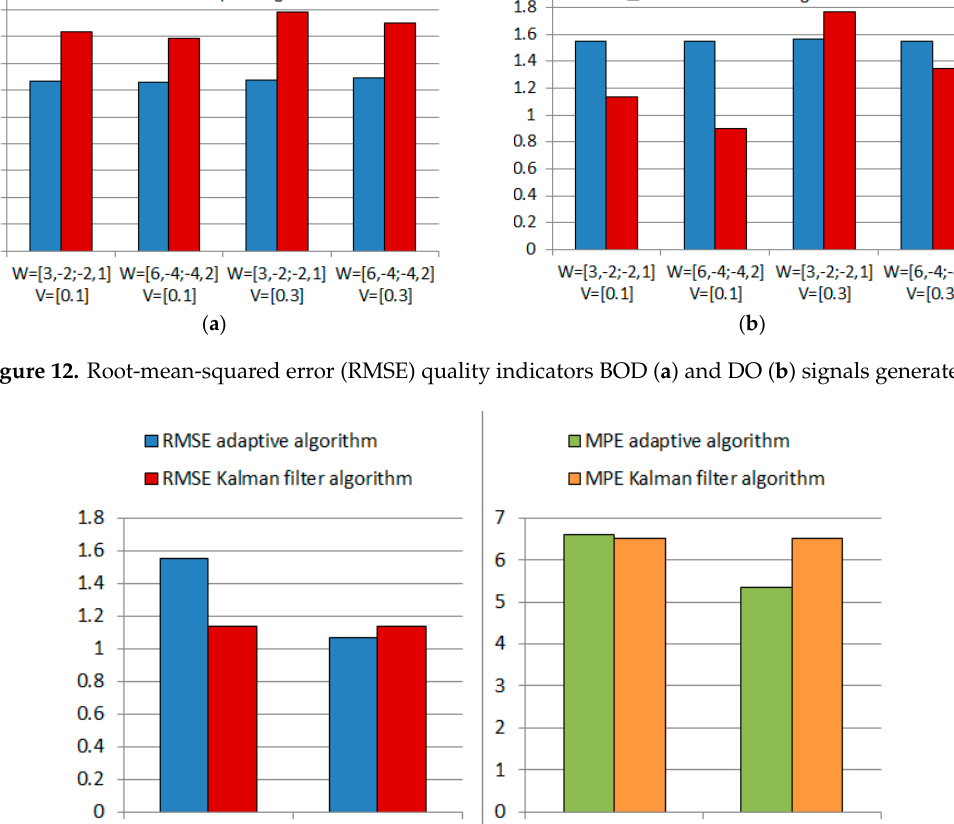
Figure 13. Values of quality indicators for DO signal at different initial gain values.